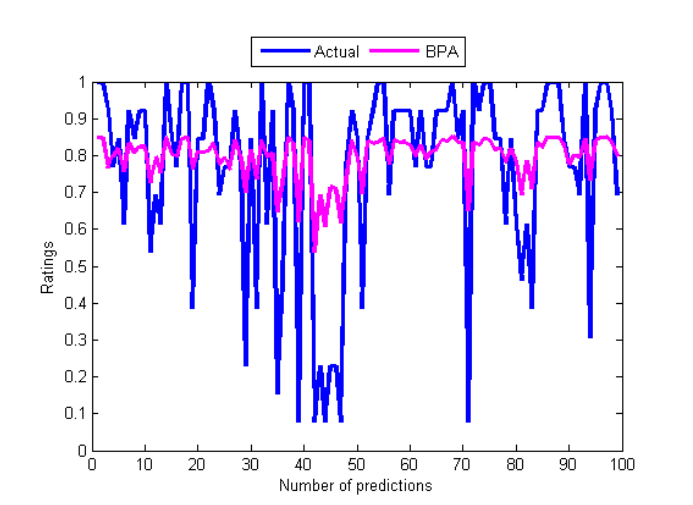
Figure 9. Curves of actual ratings and predicted ratings of